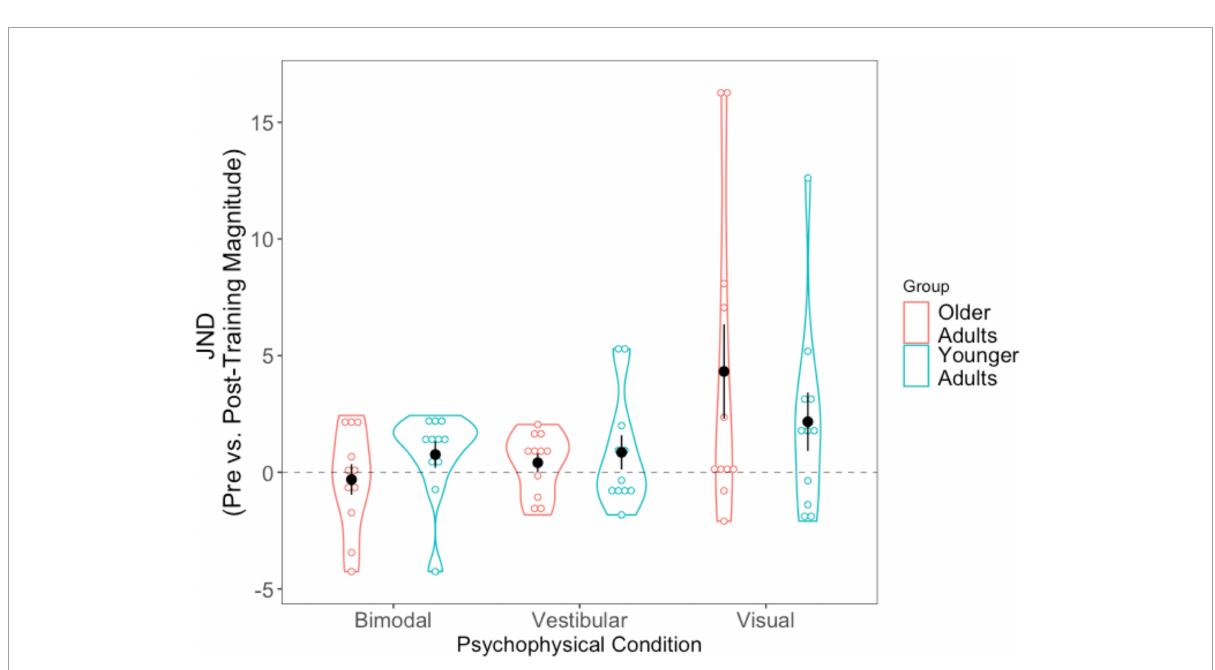
FIGURE6 Difference scores for JNDs, across all three psychophysical conditions, for each of the two age groups. Black dots represent means, and error bars represent standard error. Individual data points are represented by the blue (younger adults) and red (older adults) circles. Positive values indicate improvement. Black dashed line represents “0” (i.e., no change after